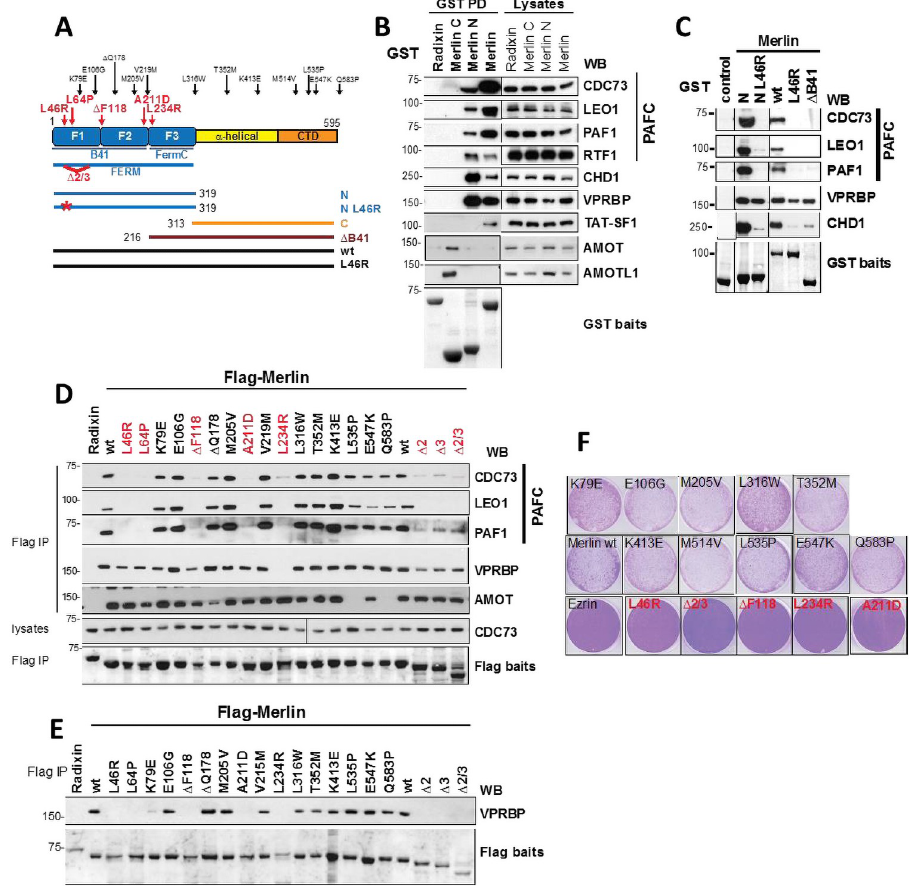
Fig 2. Loss of function mutations in Merlin disrupt the interaction with the PAFC. (A) Schematic of Merlin constructs used. (B) Merlin’s FERM domain mediates the interaction with the PAFC, CHD1 and VPRBP whereas AMOT and AMOTL1 bind to Merlin’s C-terminus. TAT-SF1 only associates with full length Merlin. GST-Merlin and -Radixin were transfected and purified from HEK293T cells and bound proteins detected by wb. (C) The PAFC, CHD1 and VPRBP bind to different regions of Merlin’s FERM domain. Recombinant GST-proteins were used in ‘fishing’ experiments from cell lysates and associated proteins detected by wb. (D) Mutations in Merlin selectively disrupt interactions. Flag-Merlin was immunoprecipitated from HEK293T cells and endogenous proteins detected by wb. (E) B41-domain Merlin mutants are defective for VPRBP binding under more stringent experimental conditions. As in E but cells were lysed and IPs washed in RIPA buffer containing 0.5% DOC, 0.1% SDS. (F) Inhibition of cell proliferation by Merlin correlates with its ability to interact with the PAFC. Clonogenic assays of SF Merlin-deficient SF1335 meningioma cells infected with retroviruses expressing either Ezrin, Merlin wt or Merlin mutants and stained with crystal